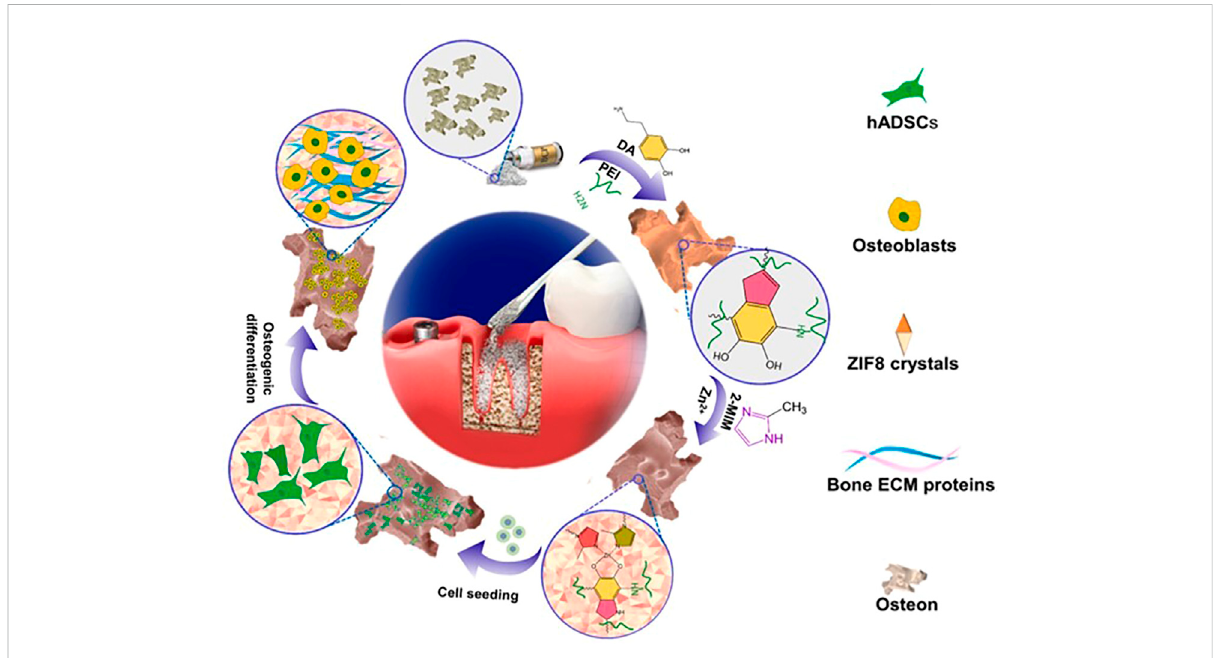
FIGURE 7 A scheme for the fabrication of ZIF-8-osteon and the process of promoting osteo-conductivity and osteo-inductivity in osteocytes ((Fardjahromi et al., 2021).